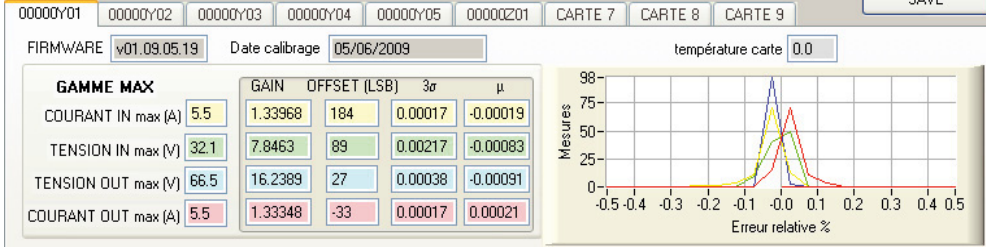
Fig. 12. Autonomous software calibration.